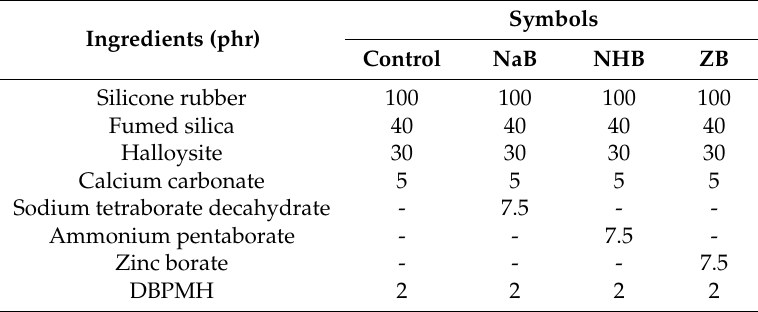
Table 1. The formulations of ceramizable MVQ/HNT composites.